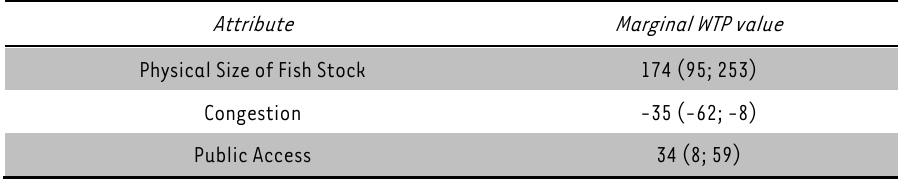
TABLE 6: Marginal WTP (MWTP) for attributes (ZAR)